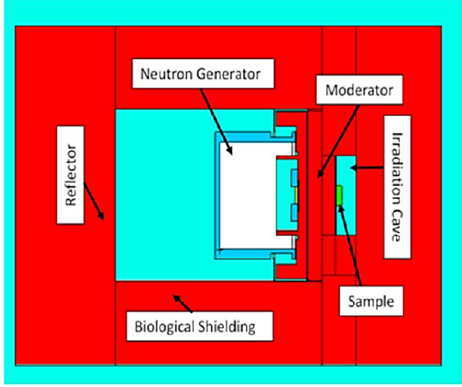
Figure 1. In vivo neutron irradiation assembly along with the components (moderator, reflector, biological shielding) was modeled in MCNP (XY view of the assembly shown here. (created with MCNP 6.1 https:// laws. lanl. gov/ vhosts/ mcnp. lanl. gov/ index.